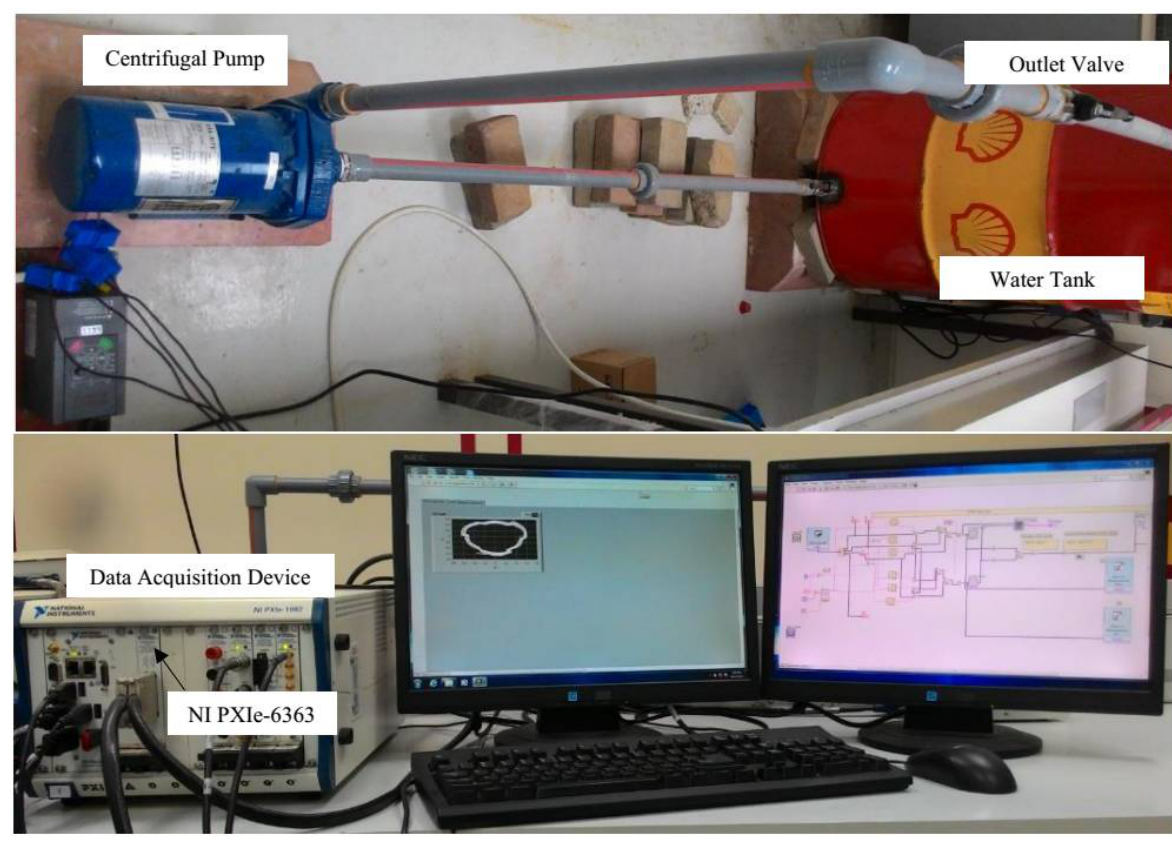
Figure 4. The photo of the experiment test rig.